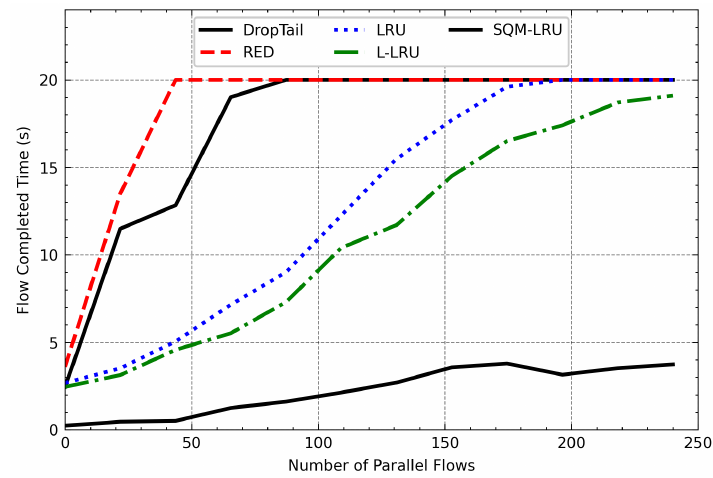
Figure 16. The FCT of FTP varies with the number of parallel flows.